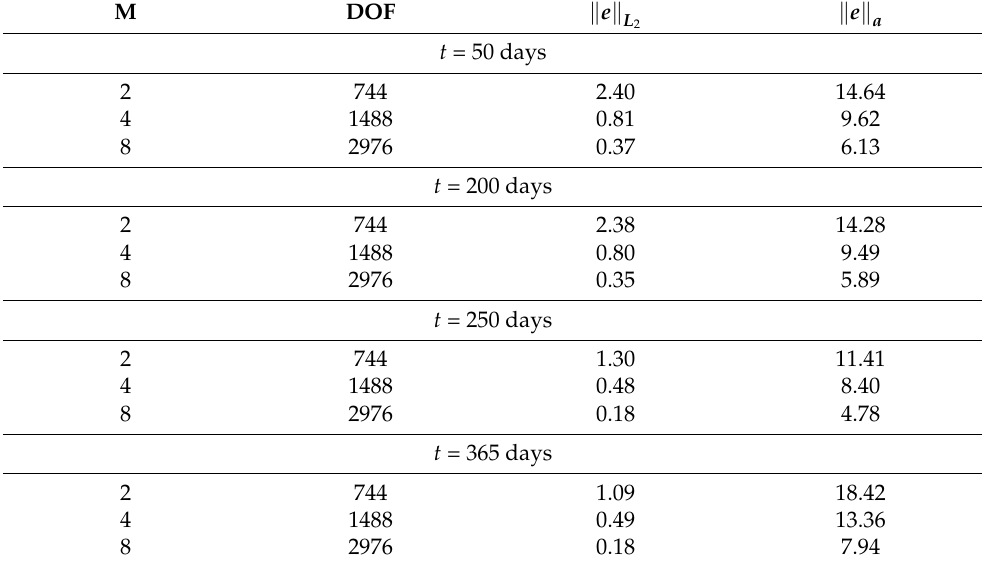
Table 6. Relative L 2 and energy errors (%) for different number of multiscale basis functions (DOF f = 207,599). Case 4: random distribution of steel